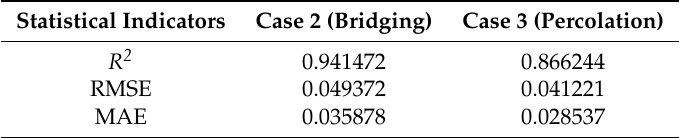
Table 2. Verification of fine sediment distribution with Gibson’s measurement